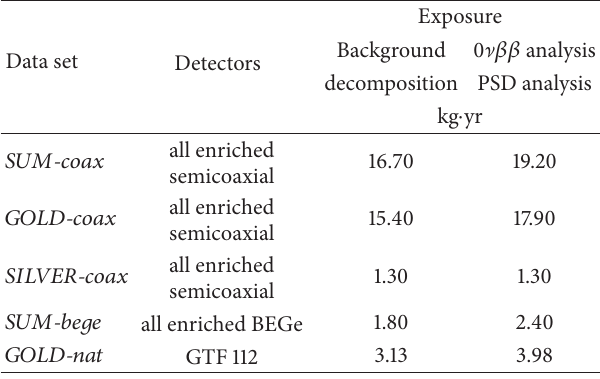
Table 2: Data sets, the detectors used and their exposure are listed for the data used for the background decomposition, PSD and 0 ] 𝛽𝛽